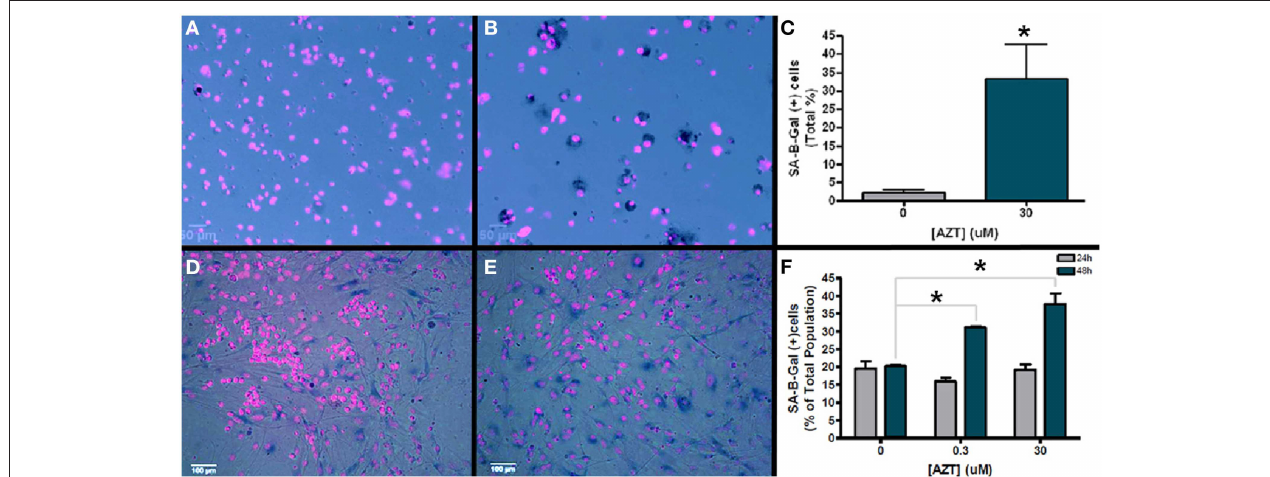
case, untreated control astrocytes (D) show a higher baseline level of SA-B-Gal labeling than dissociated neurospheres, but the AZT-treated astrocytes (E) show a clear and substantial upregulation of this senescence marker. Graphical data for astroctyes (F) shows that 0.3 and 30 µ M AZT for 48h. (green bars) cause a respective 50 and 75% increase in SA-B-Gal+ cells (One-Way ANOVA, Dunnett’s multiple comparison test of significance, p < 0 . 01 ). However, 24h. exposure (gray bars) to these concentrations does not significantly alter SA-B-Gal expression. Asterisks indicate values significantly different from control; error bars represent standard deviation. N = 3 for all groups; error bars represent standard